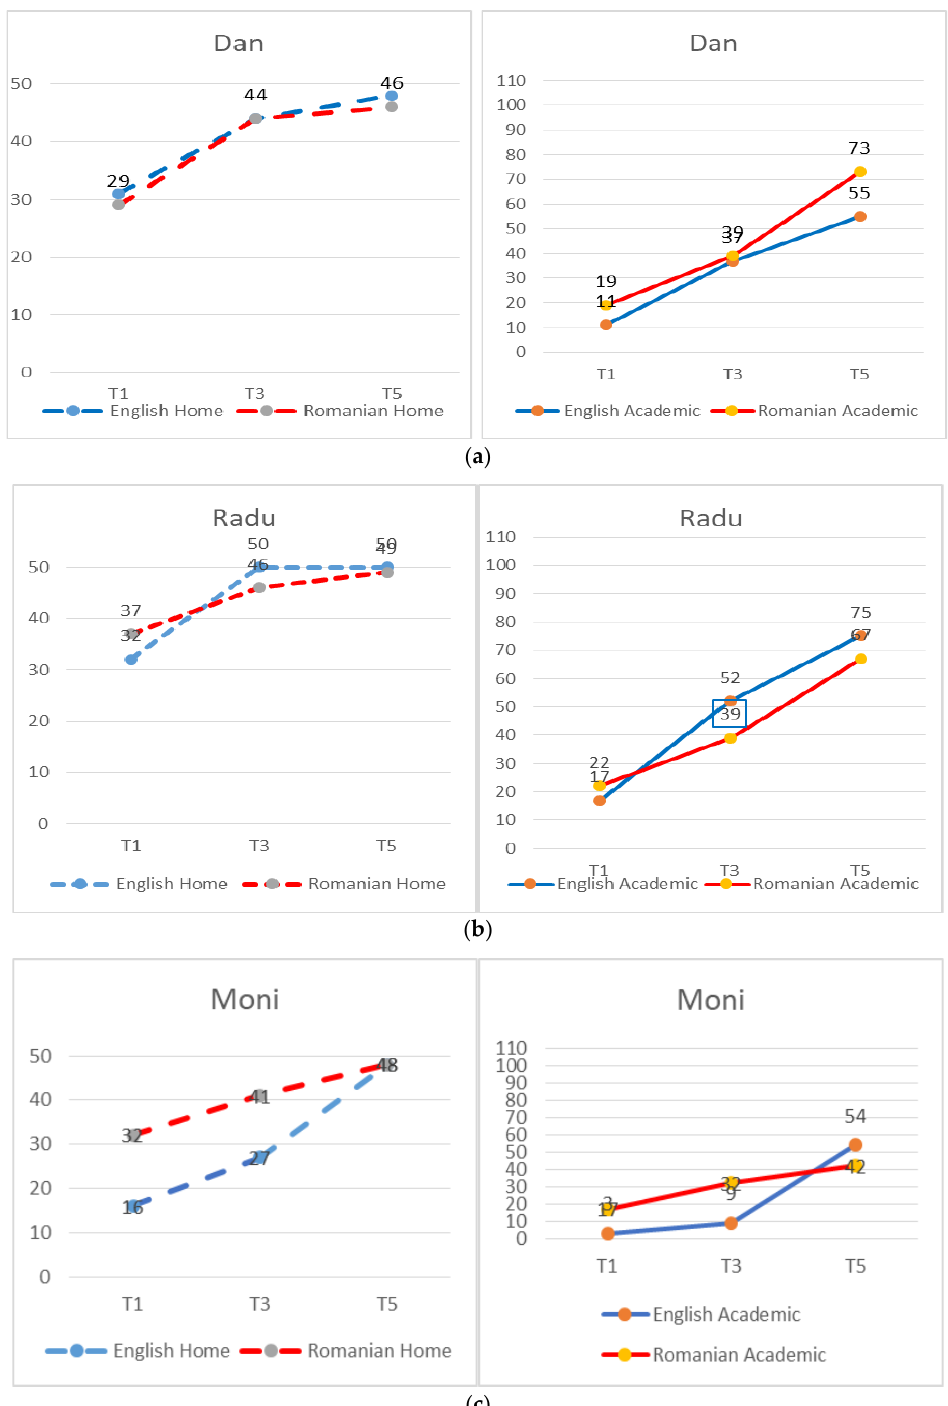
Figure 3. PPVT 4—Raw scores for Romanian and English home (max = 52), and Romanian and English academic (max = 110) for ( a ) Dan; ( b ) Radu; and ( c ) Moni.